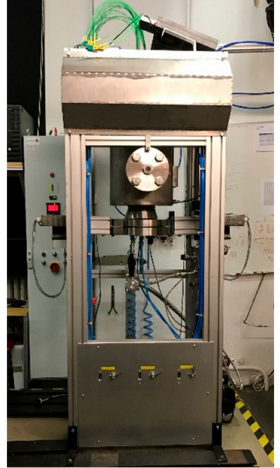
Figure 3. Current setup of the test plant